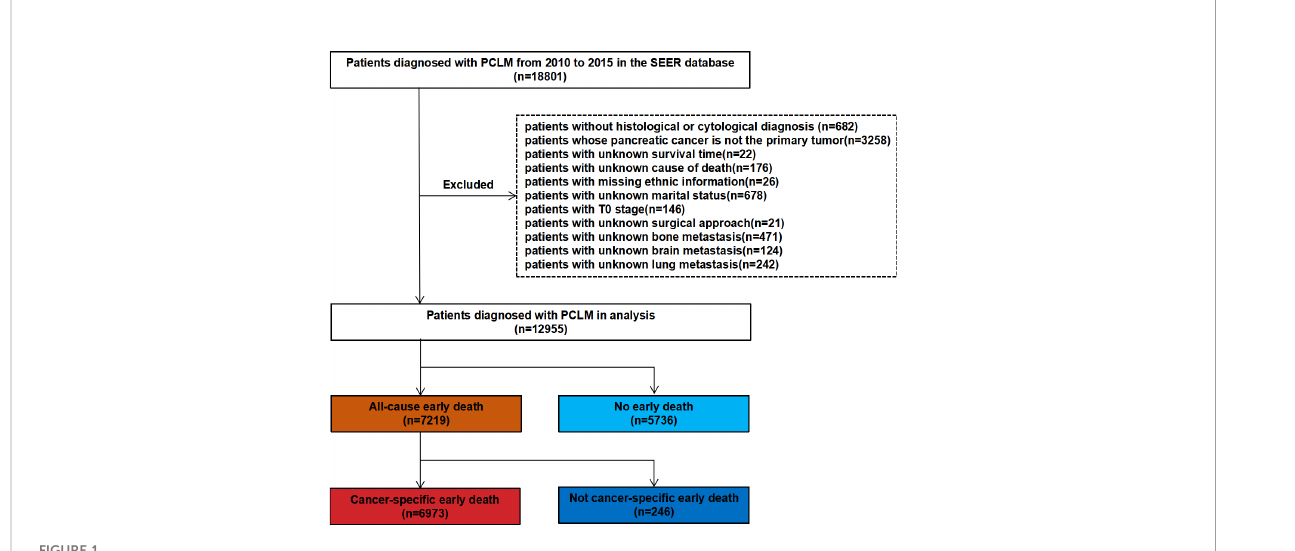
FIGURE 1 The fl owchart of patient selection from SEER